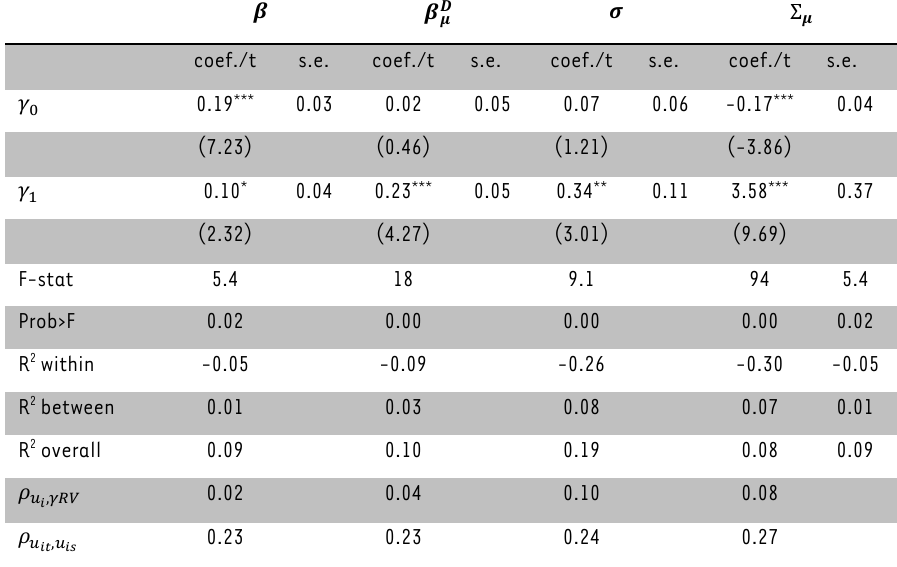
TABLE 3: Heteroscedasticity-consistent simple regression: risk variables 𝜷 𝜷 𝝁𝑫 𝝈 Ʃ 𝝁 coef./t s.e. coef./t